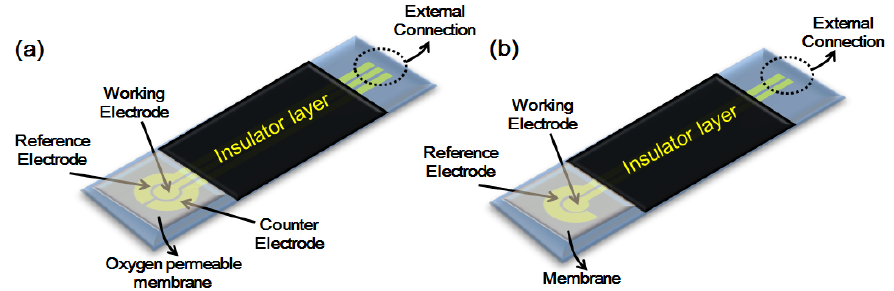
Figure 2. Showing ( a ) amperometric and ( b ) potentiometric electrode configurations.